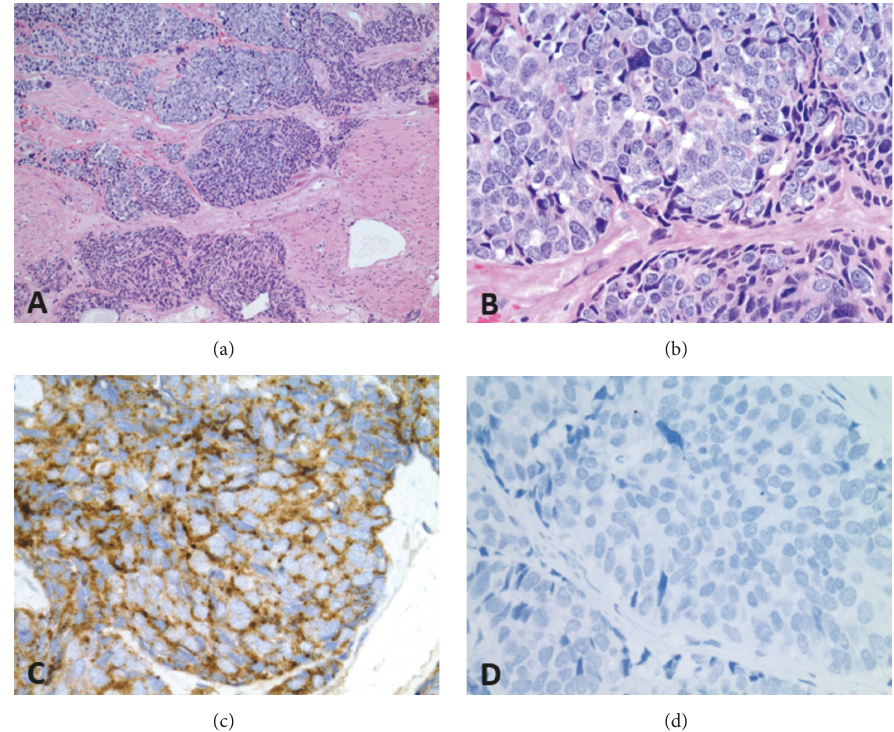
Figure 2: Histopathology of the resected bladder lesion. (a) Low-power field H&E stain reveals invasive poorly differentiated carcinoma infiltrates lamina propria and muscularis propria. (b) High-power field H&E stain reveals large polygonal-shape cells with low nuclear to cytoplasmic ratio, coarse chromatin structure, multiple nucleoli, and high rate of mitosis. (c) Immunohistochemical stain positive for chromogranin and (d) negative for PSA.